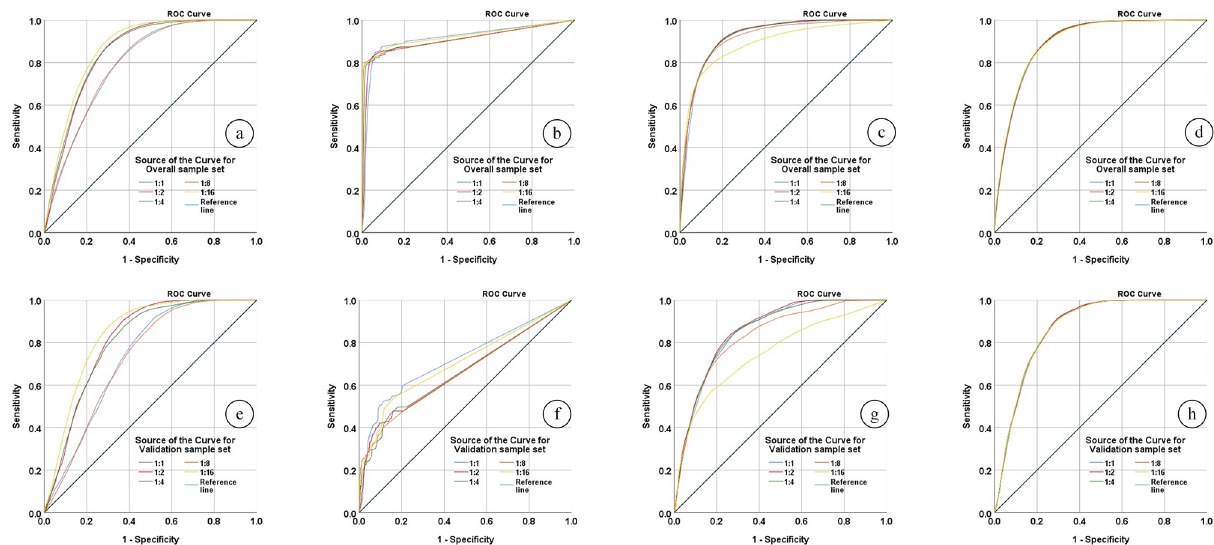
Figure 11. ROC curve analysis for ( a ) Overall sample set by CNN model, ( b ) Validation sample set by CNN model, ( c ) Overall sample set by C5.0 model, ( d ) Validation sample set C5.0 model, ( e ) Overall sample set by